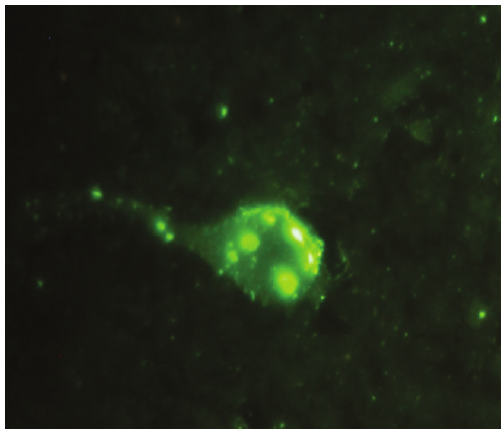
Figure 1: Fluorescent antibody technique (FAT) on human brain smear positive for rabies.